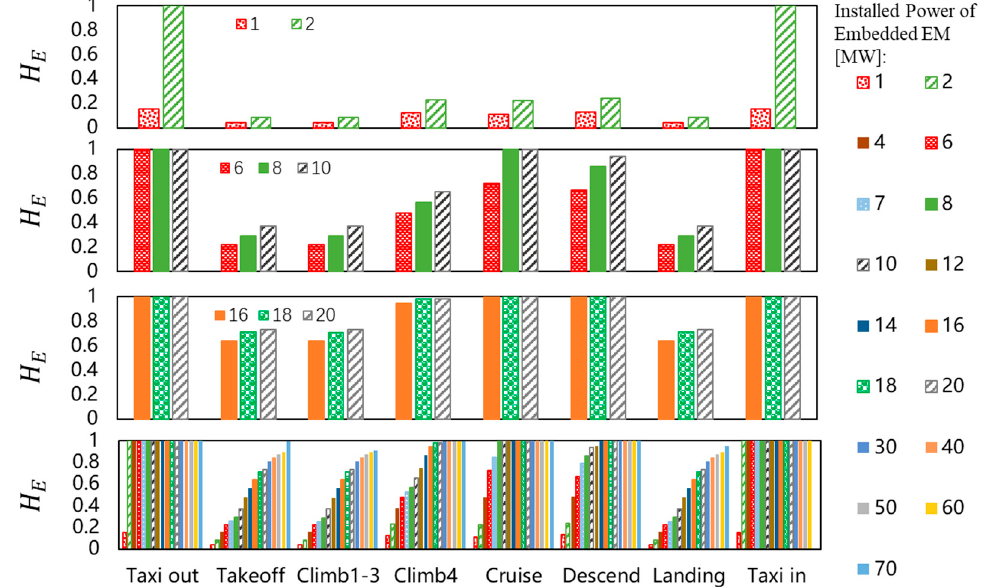
Figure 12. The variation of 𝑯 𝑬 for complete flight conditions of HEA with different levels of EM power.